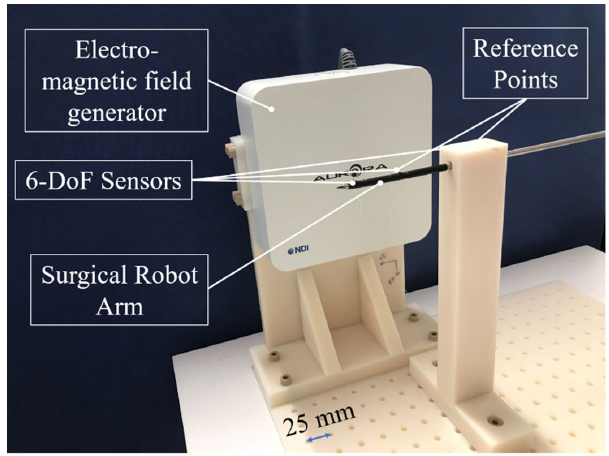
Figure 20. Experimental apparatus.